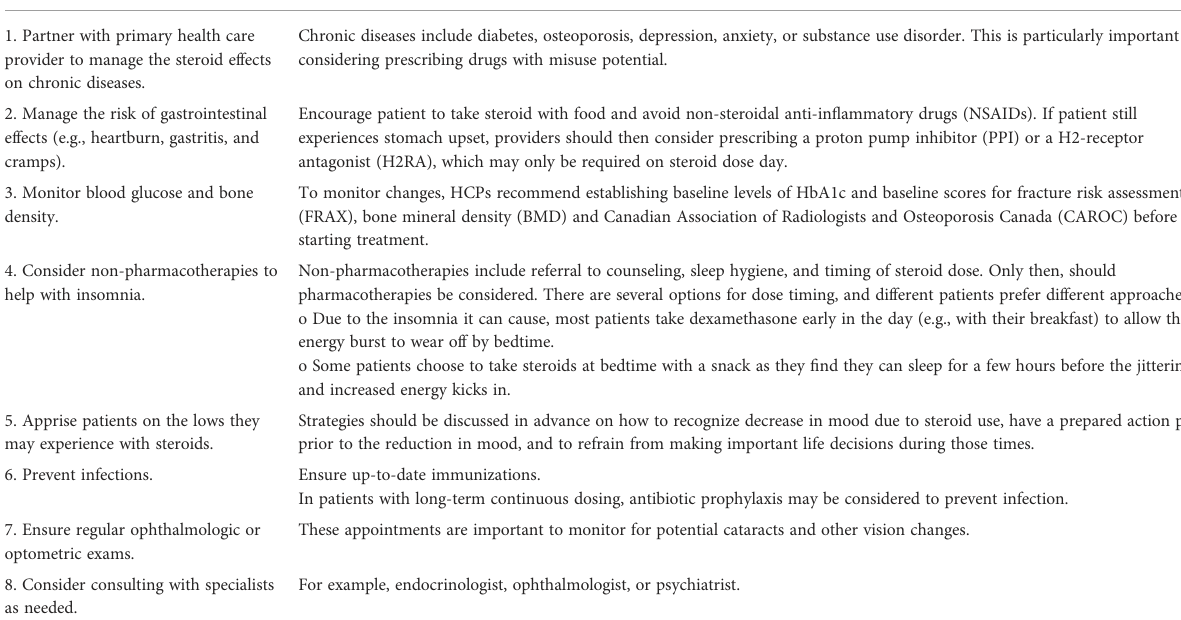
TABLE 2 Recommendations to support AE management with steroid use.